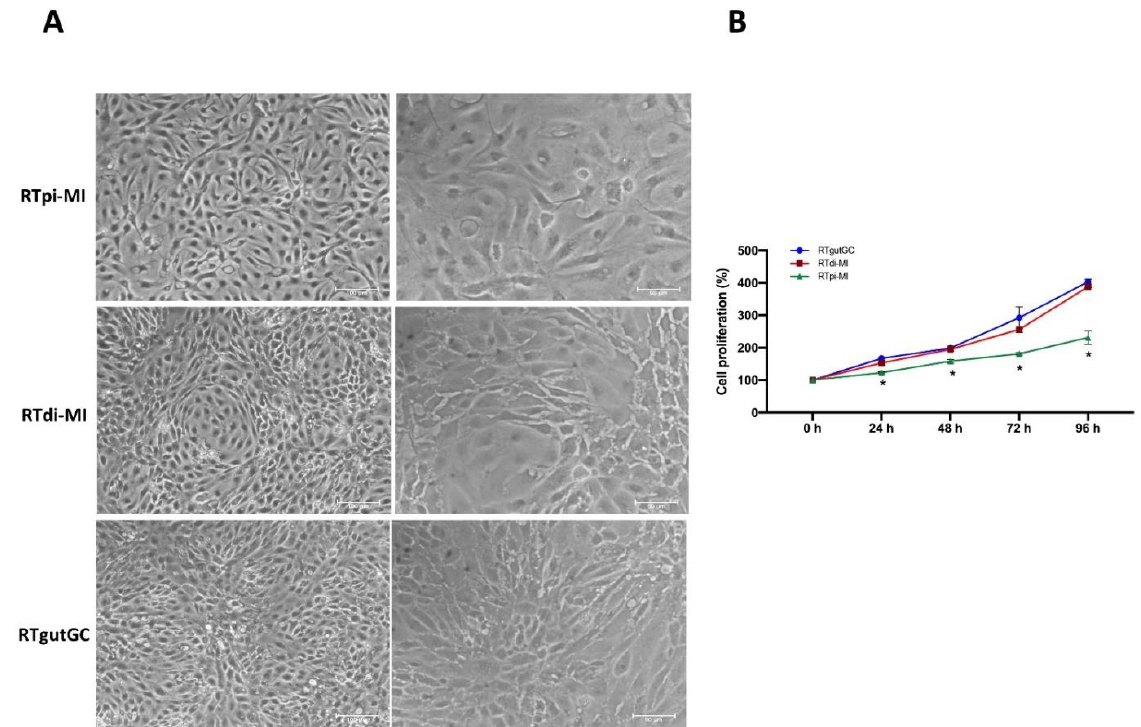
Figure 1. Morphology and cell proliferation of RTpi-MI, RTdi-MI and RTgutGC. ( A ) Representative picture of fully confluent RTpi-MI, RTdi-MI and RTgutGC cells at 20× ( left ) and 40× ( right ) magnification. Scale bar, 100 µm (left side) and 50 µm (right side). ( B ) Graphs reporting the growth curves of RTgutGC (blue line), RTdi-MI (red line) and RTpi-MI (green line) from 24 h (day 1) to 96 h (day 4) of culture showing that the RTpi-MI, derived from the proximal intestine, grew more slowly than RTgutGC and RTdi-MI cell lines, which were both derived from the distal intestine. Statistical significance for p < 0.05 is indicated as an asterisk (*). Data are reported as percentages (mean ± SD from 3 independent experiments) calculated on the cell seeding density for all cell lines.